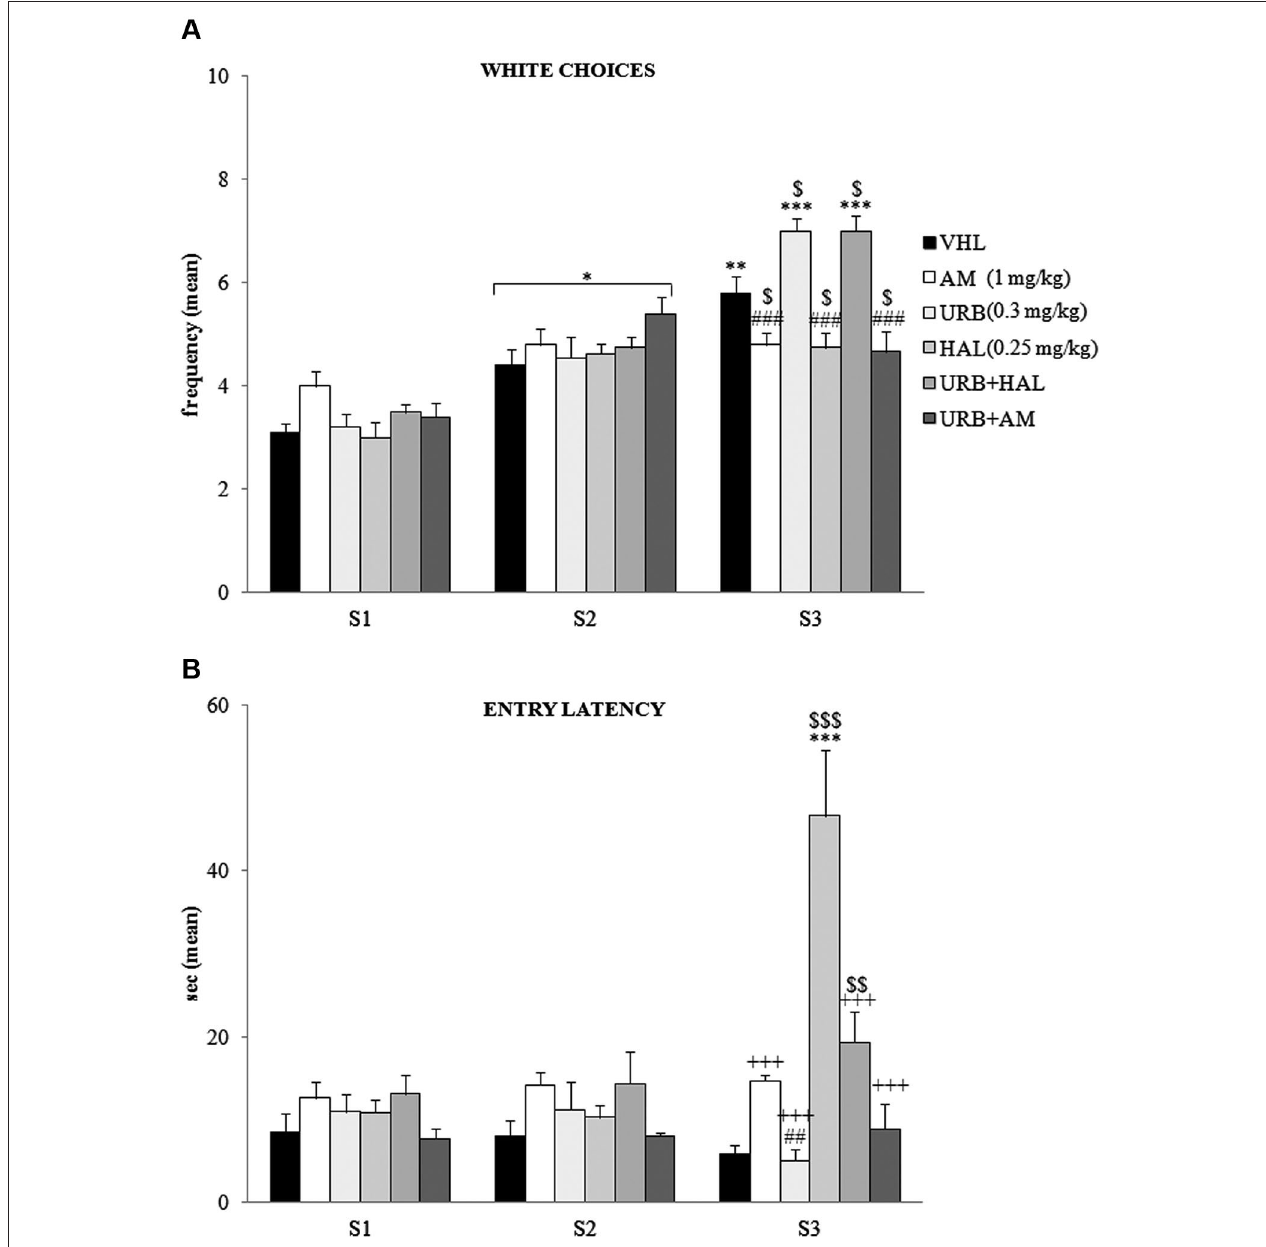
differences in entry latency were found. Between S2 and S3, the HAL group had higher latency values ( p < 0.0001, ***). In S3, the HAL group showed highest entry latency values ( vs. URB, URB+HAL, AM, URB+AM groups at least p = 0.0001, +++; vs. VHL group p = 0.0001, $$$). The haloperidol powerful effect was contrasted but not prevented by URB597 and haloperidol coadministration, as the URB+HAL group had higher latency values than the URB ( p = 0.002, ##) and VHL ( p = 0.005, $$) groups.